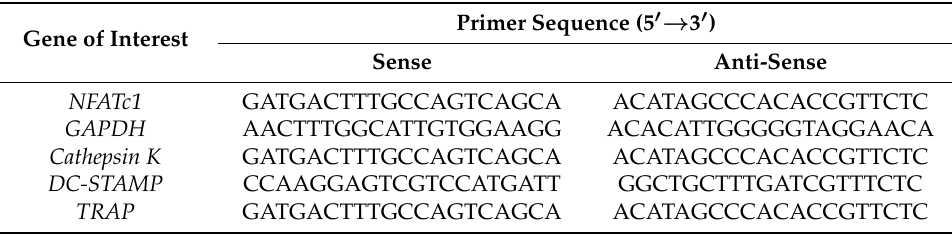
Table 1. Primer sequences used in this